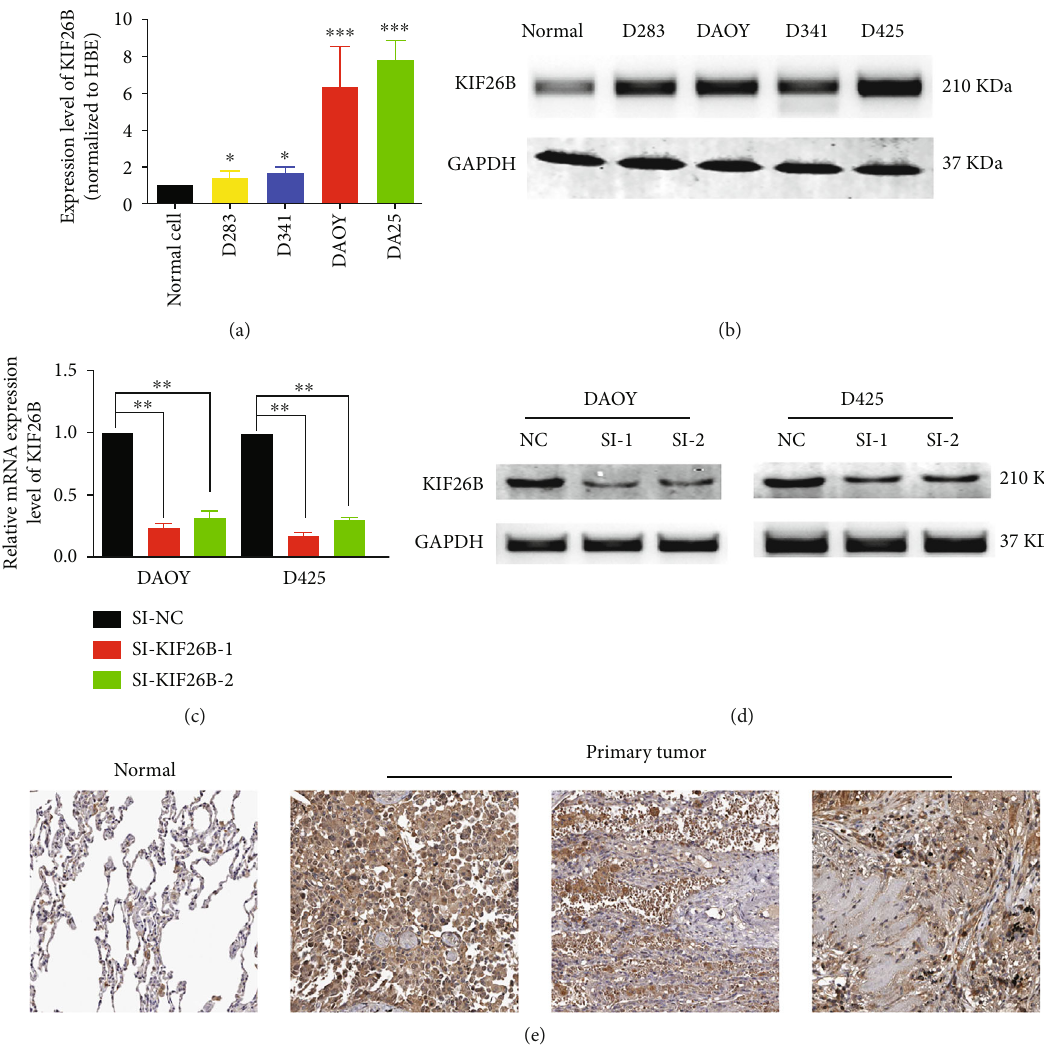
Figure 2: (a and b) PCR and western blot were used to detect the expression of KIF26B in the normal cell and medulloblastoma cell lines D283, D341, D425, and DAOY. (c and d) PCR and western blot were used to detect the expression of KIF26B in D425 and DAOY cell lines after being silenced by